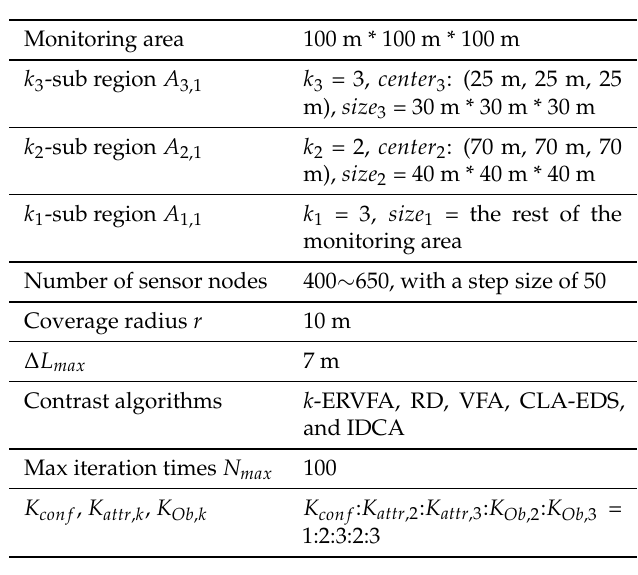
Table 5. Simulation parameters. RD, Random Deployment; CLA-EDS, a Cellular Learning Automata-based Enhanced Deployment Strategy; IDCA, Intelligent Deployment and Clustering